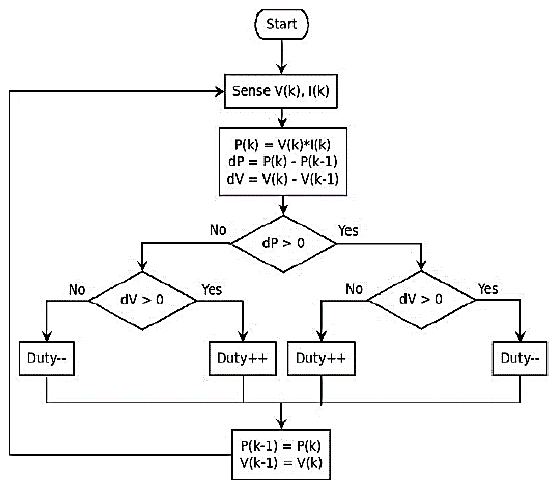
Figure 3. Flowchart of the P&O algorithm.